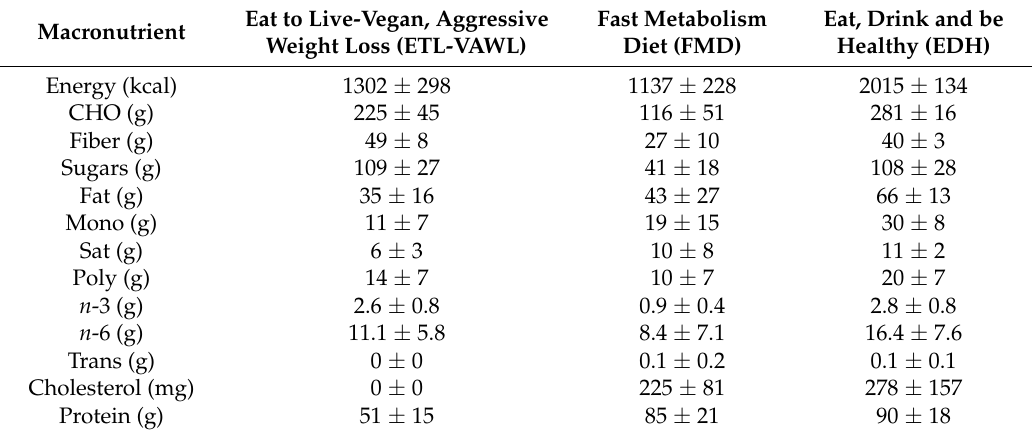
Table 2. Macronutrient content of three weight-loss diet plans *.